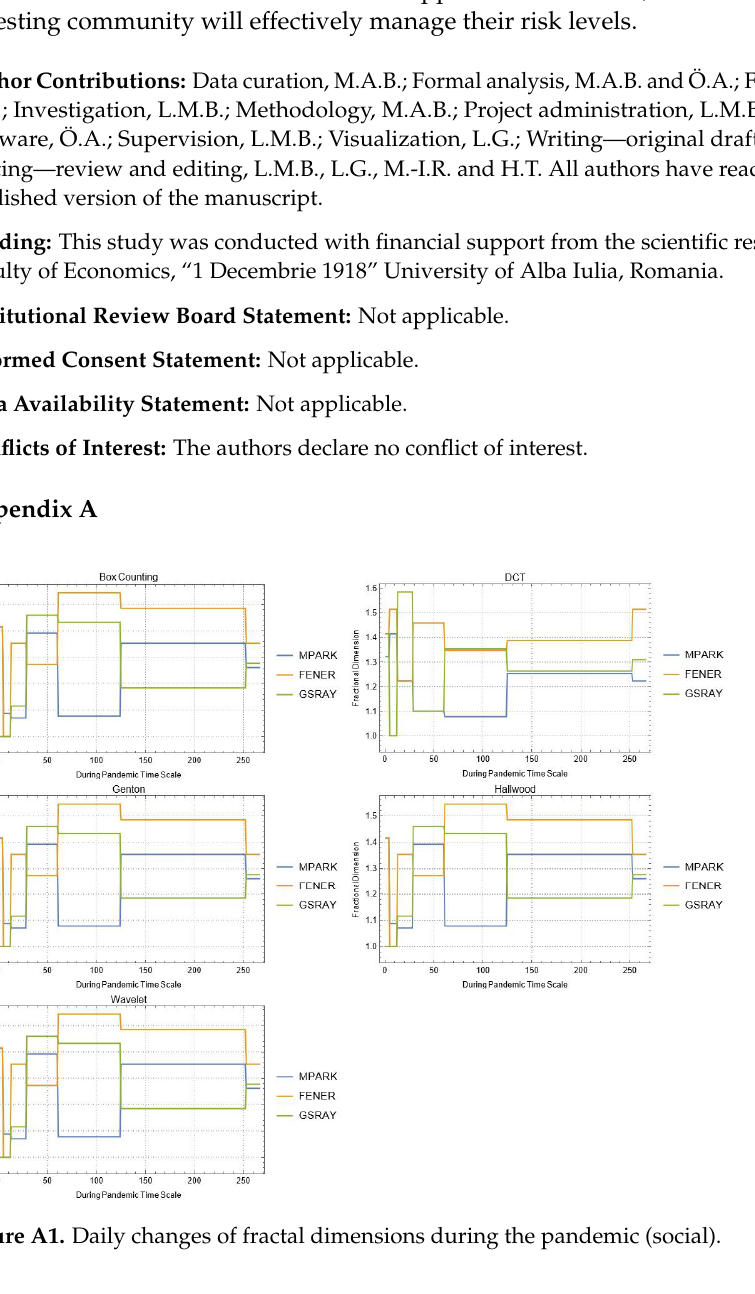
Figure A2. Daily changes of fractal dimensions during the pandemic (energy).